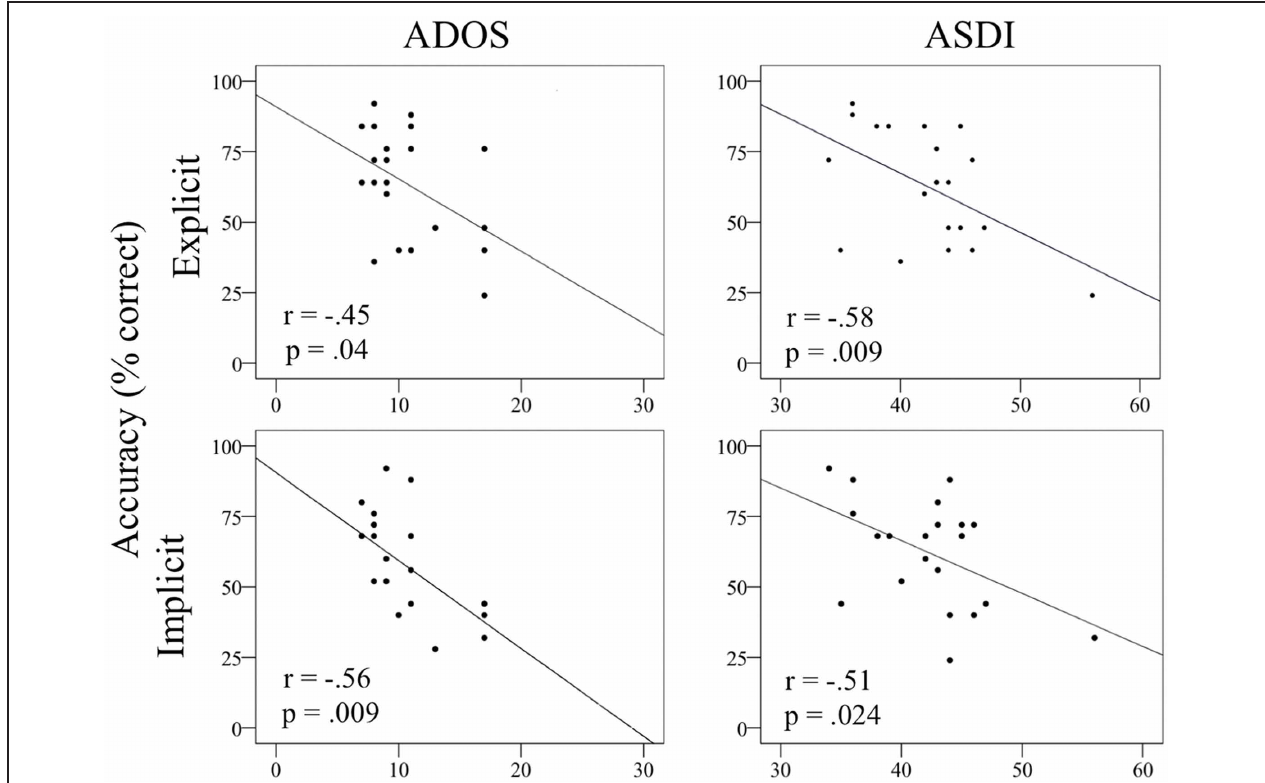
FIGURE 4 | Scatter plots displaying the correlation between diagnostic scores and accuracy (% correct responses) in the Face Puzzle implicit and explicit task for the ASD group. Upper: Face Puzzle explicit task,